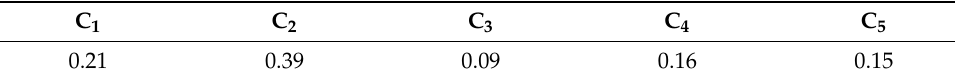
Table 13. Criteria weightings.